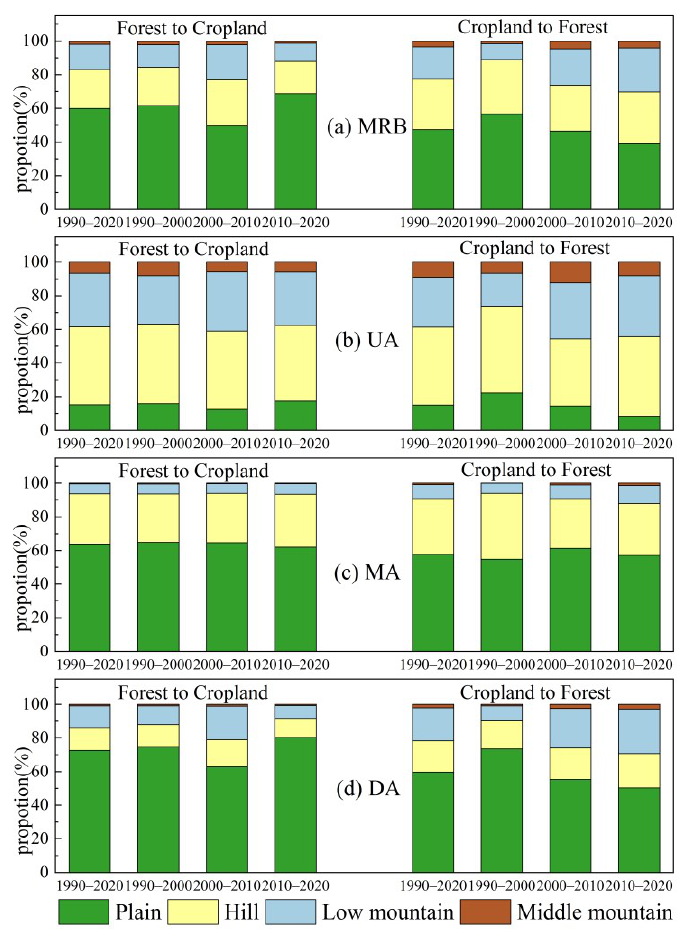
Figure 5. The proportion of conflicts between cropland and forest at different elevation gradients in the ( a ) Mekong River Basin (MRB) and its ( b ) upstream area (UA), ( c ) midstream area (MA), and ( d ) downstream area (DA) during 1990–2020, 1990–2000, 2000–2010, and